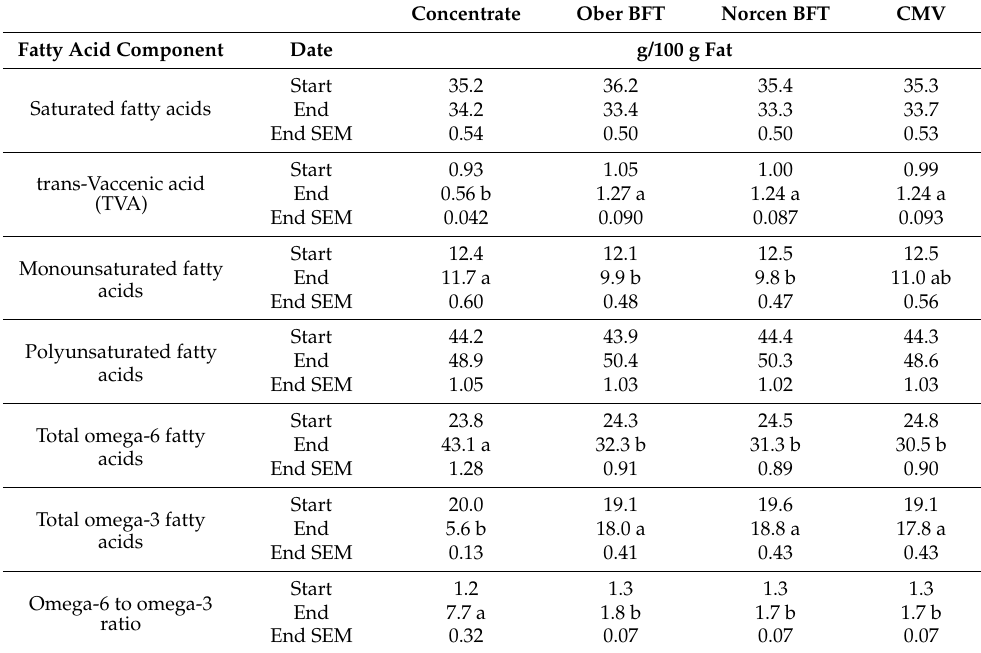
Table 6. LSMEANS of 2012 cattle blood plasma fatty acid composition at the beginning (31 May) and end (23 August) of an 84-d feeding period on a concentrate diet or on perennial legume pastures. Concentrate Ober BFT Norcen BFT Fatty Acid Component